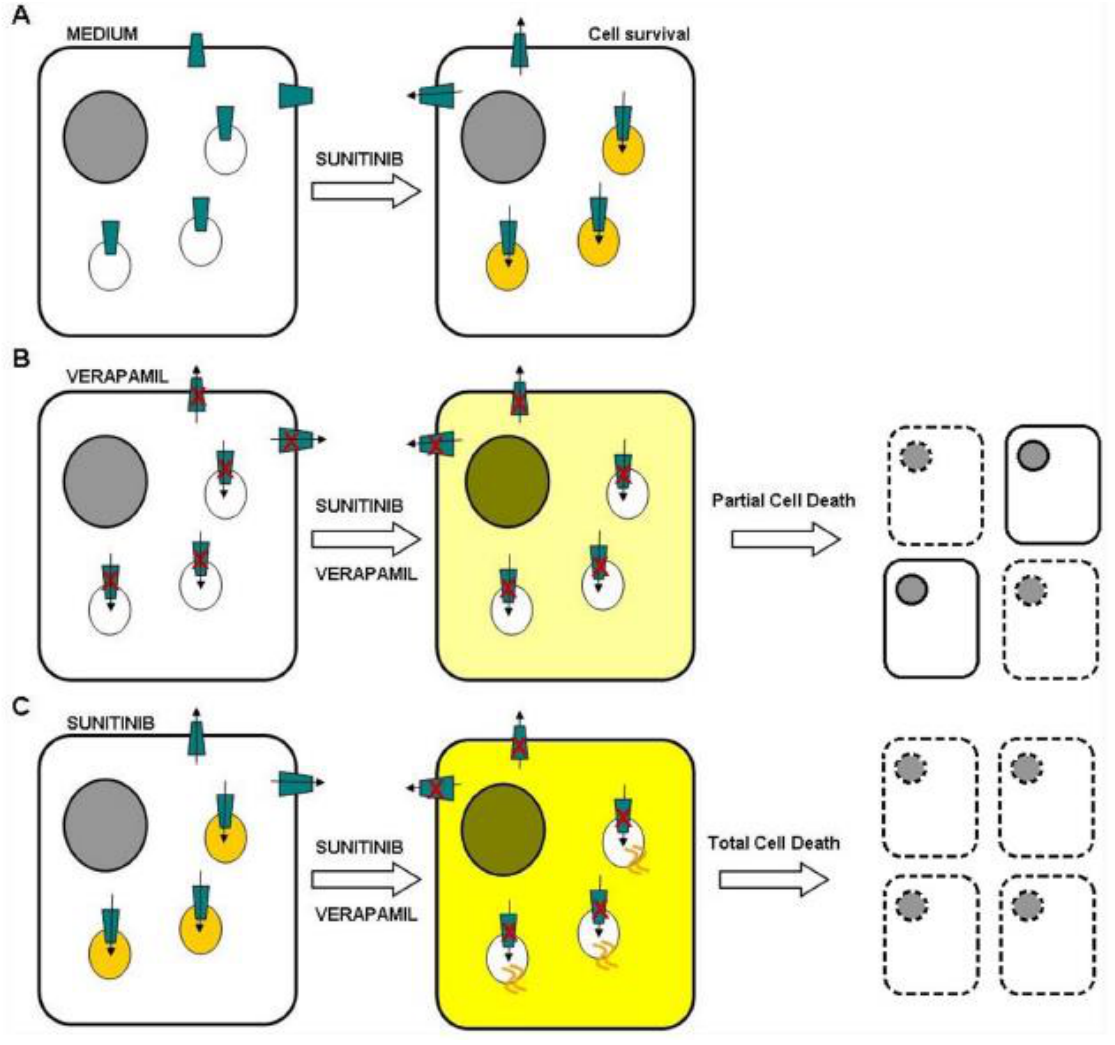
Figure 2. Hypothesized mechanism of the enhanced efficacy of drug pretreatment before verapamil administration and PGP blockade. A. HCC cells expressing active PGP can expel a drug (e.g., sunitinib) from the cytoplasm or store it in lysosomes. B. Blocking PGP with verapamil before the coadministration of sunitinib and verapamil allows the drugs to enter the cell and diffuse into cytoplasm/nucleus. C. If sunitinib is used for pretreatment, it is stored in giant lysosomes, and after the coadministration of sunitinib and verapamil and subsequent PGP blockade, the drugs can enter the cytoplasm/nucleus from both extracellular space and the lysosomes